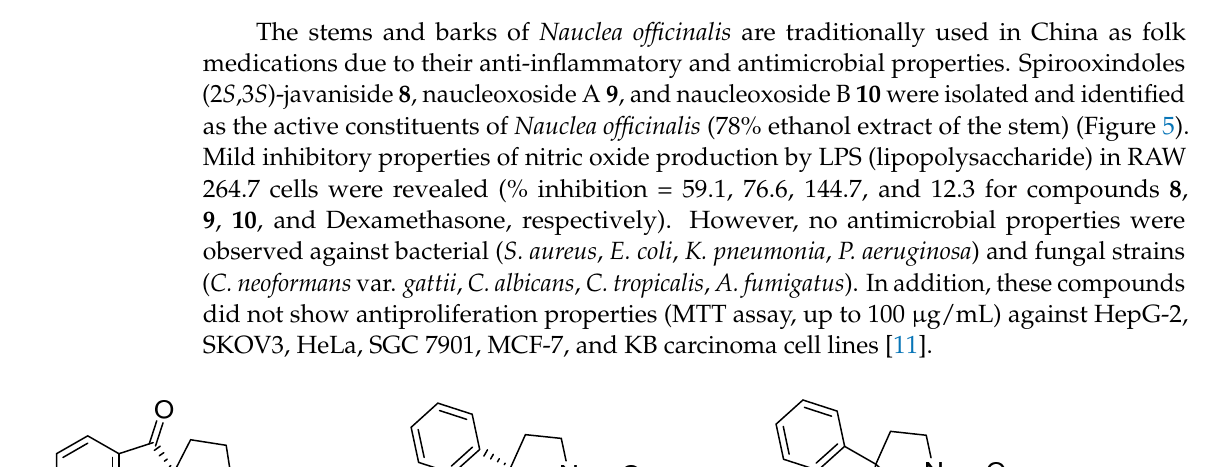
Figure 4. Spirooxindole alkaloids 4–7 isolated from the leaves of Malaysian Mitragyna speciosa (Kratom).